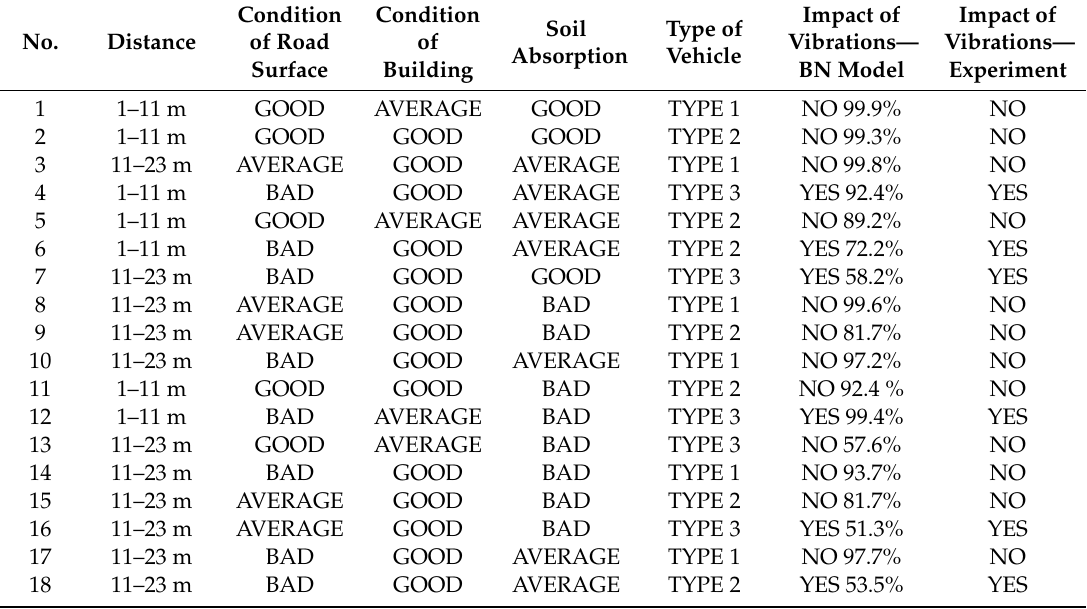
Table 2. Characteristics of the input predictors and results of